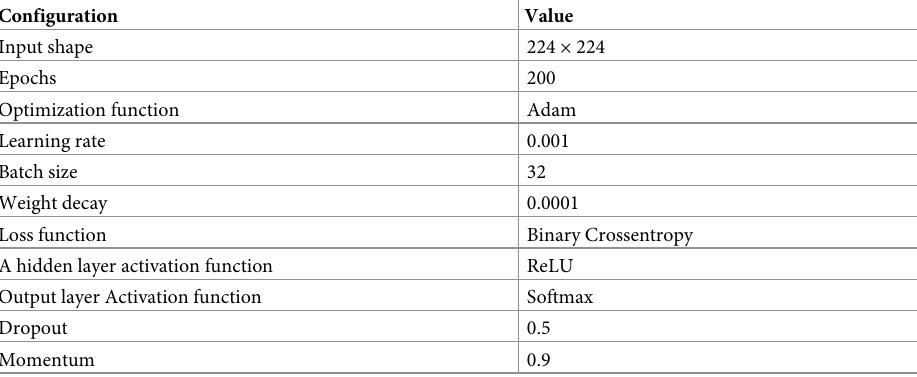
Table 14. Configuration of optimal model based on hyper-parameters.